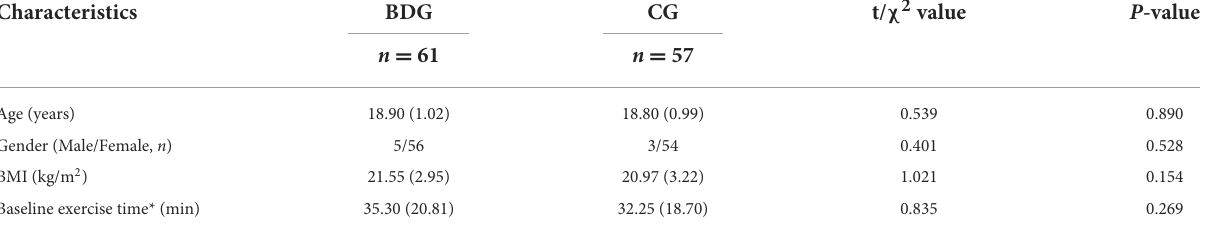
TABLE 1 Baseline characteristics of the participants [mean